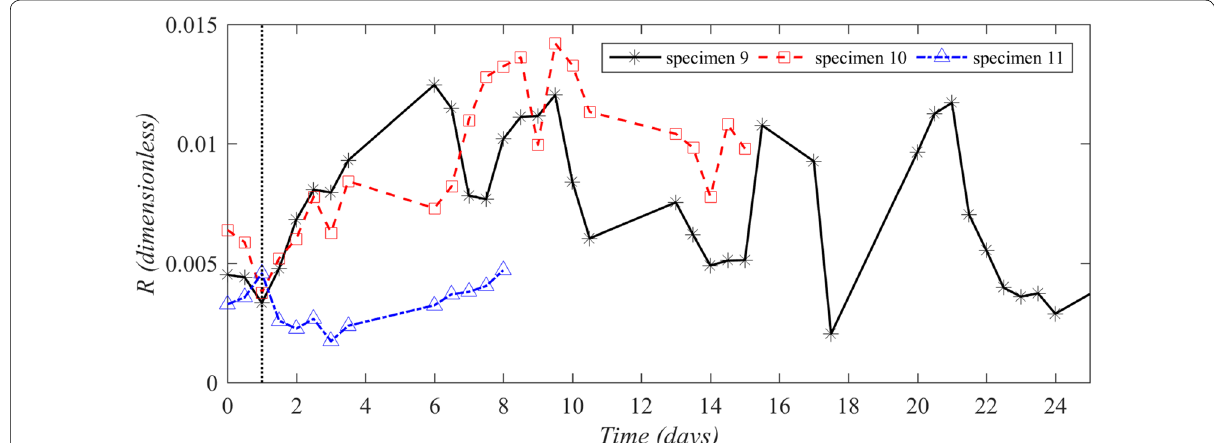
Fig. 13 Evolutions of the values of parameter R with time. The emitter transducer was supplied with two tones at the same time ( f 1 2 kHz), and excited with 180 V. The vertical line ( t f 0 =